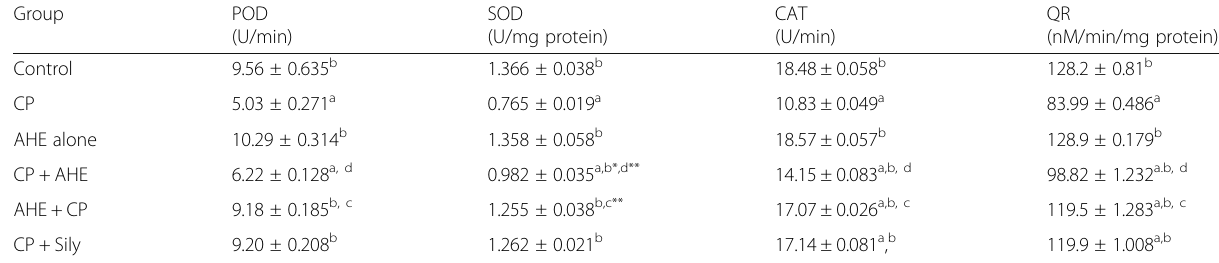
Table 3 Effect of cisplatin (CP) and different treatments of AHE on lung tissue antioxidant enzymes